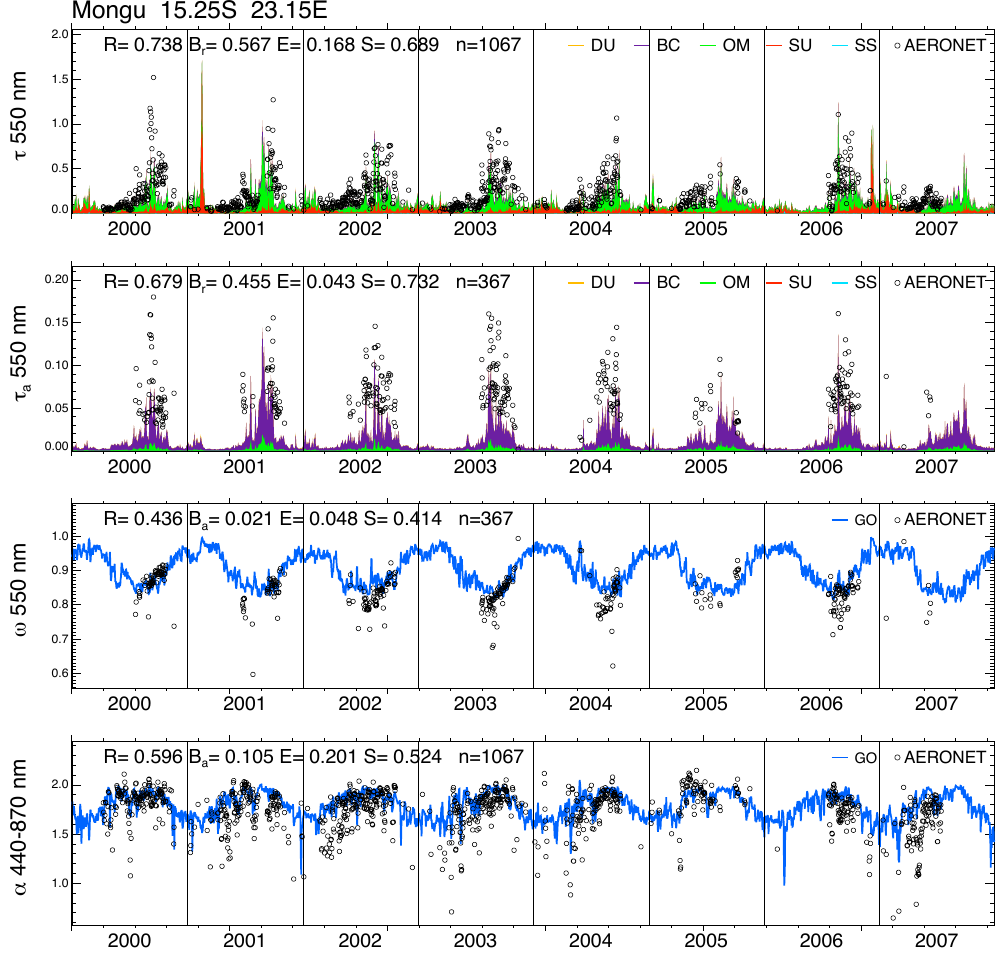
Fig. 5g. Same as Fig. 5a but for Mongu,